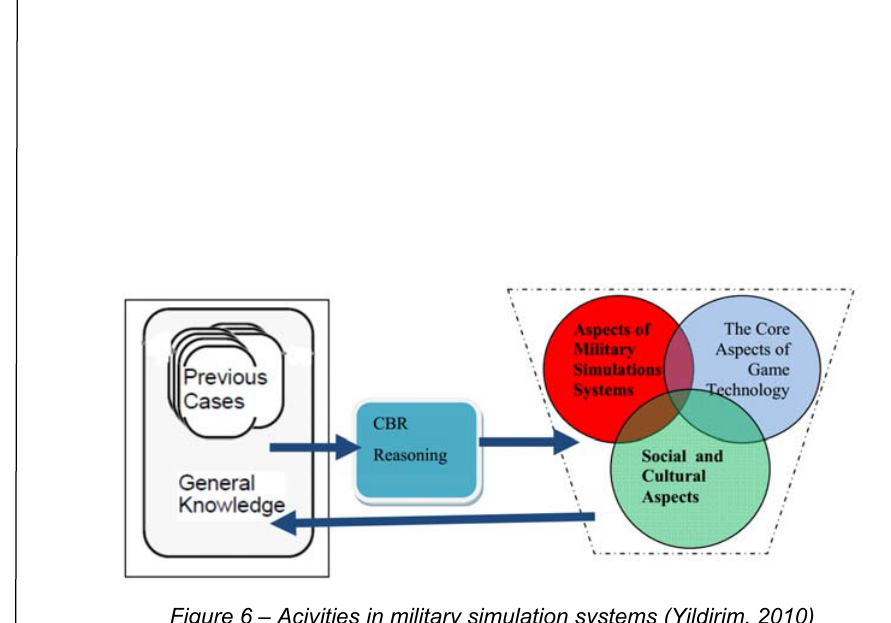
Figure 6 – Acivities in military simulation systems (Yildirim, 2010) Рис . 6 – Активности в рамках военного моделирования (Yildirim, 2010) Слика 6 – Активности у оквиру система војне симулације (Yildirim,